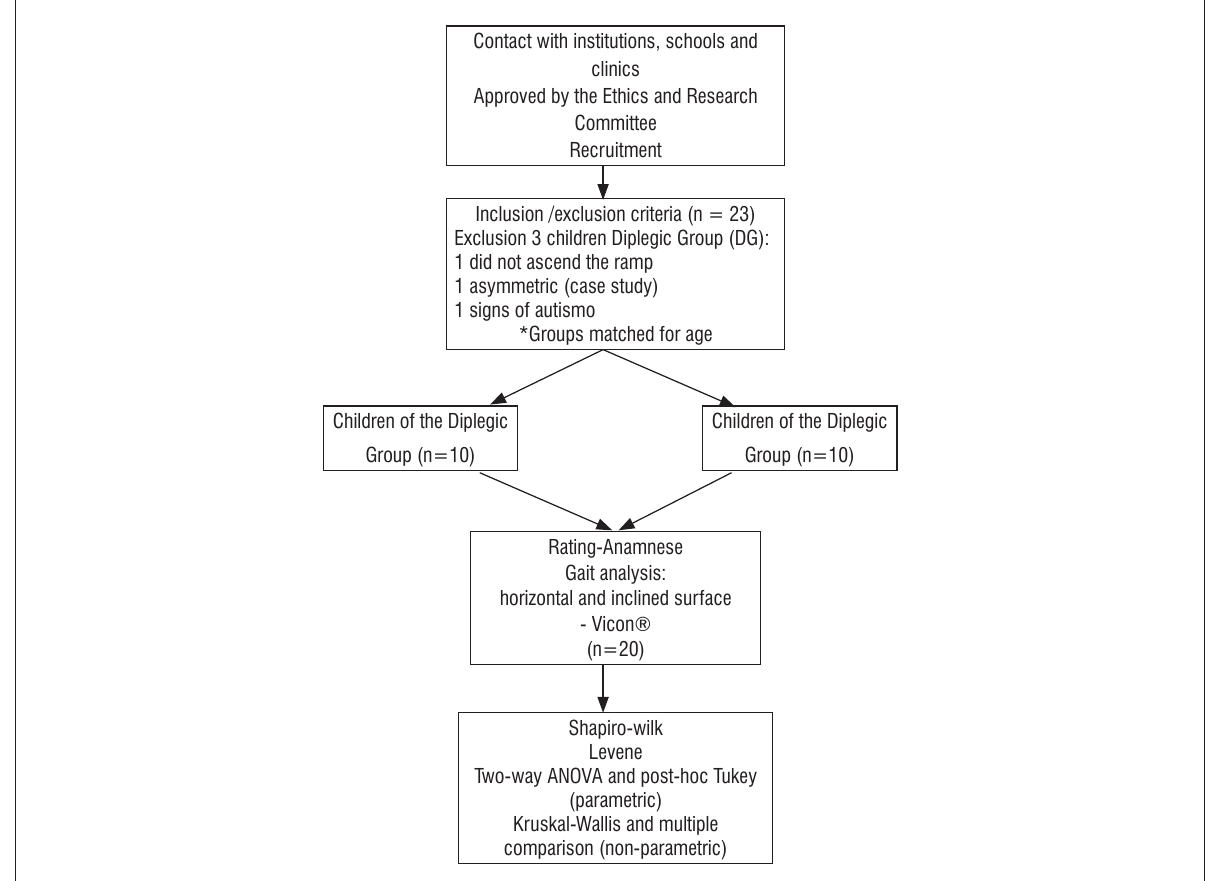
Figure 1 - Study experimental design